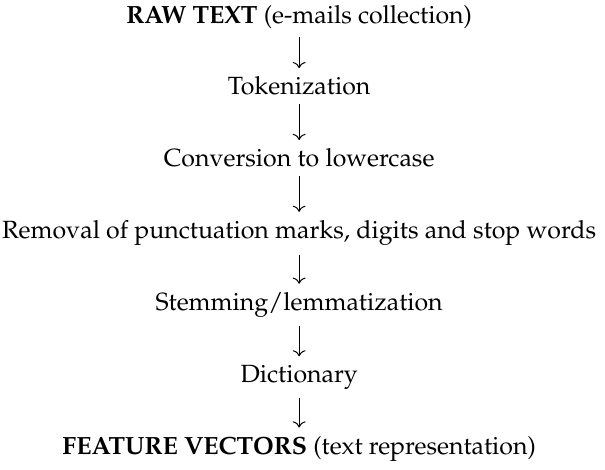
Figure 2. Text preprocessing steps.